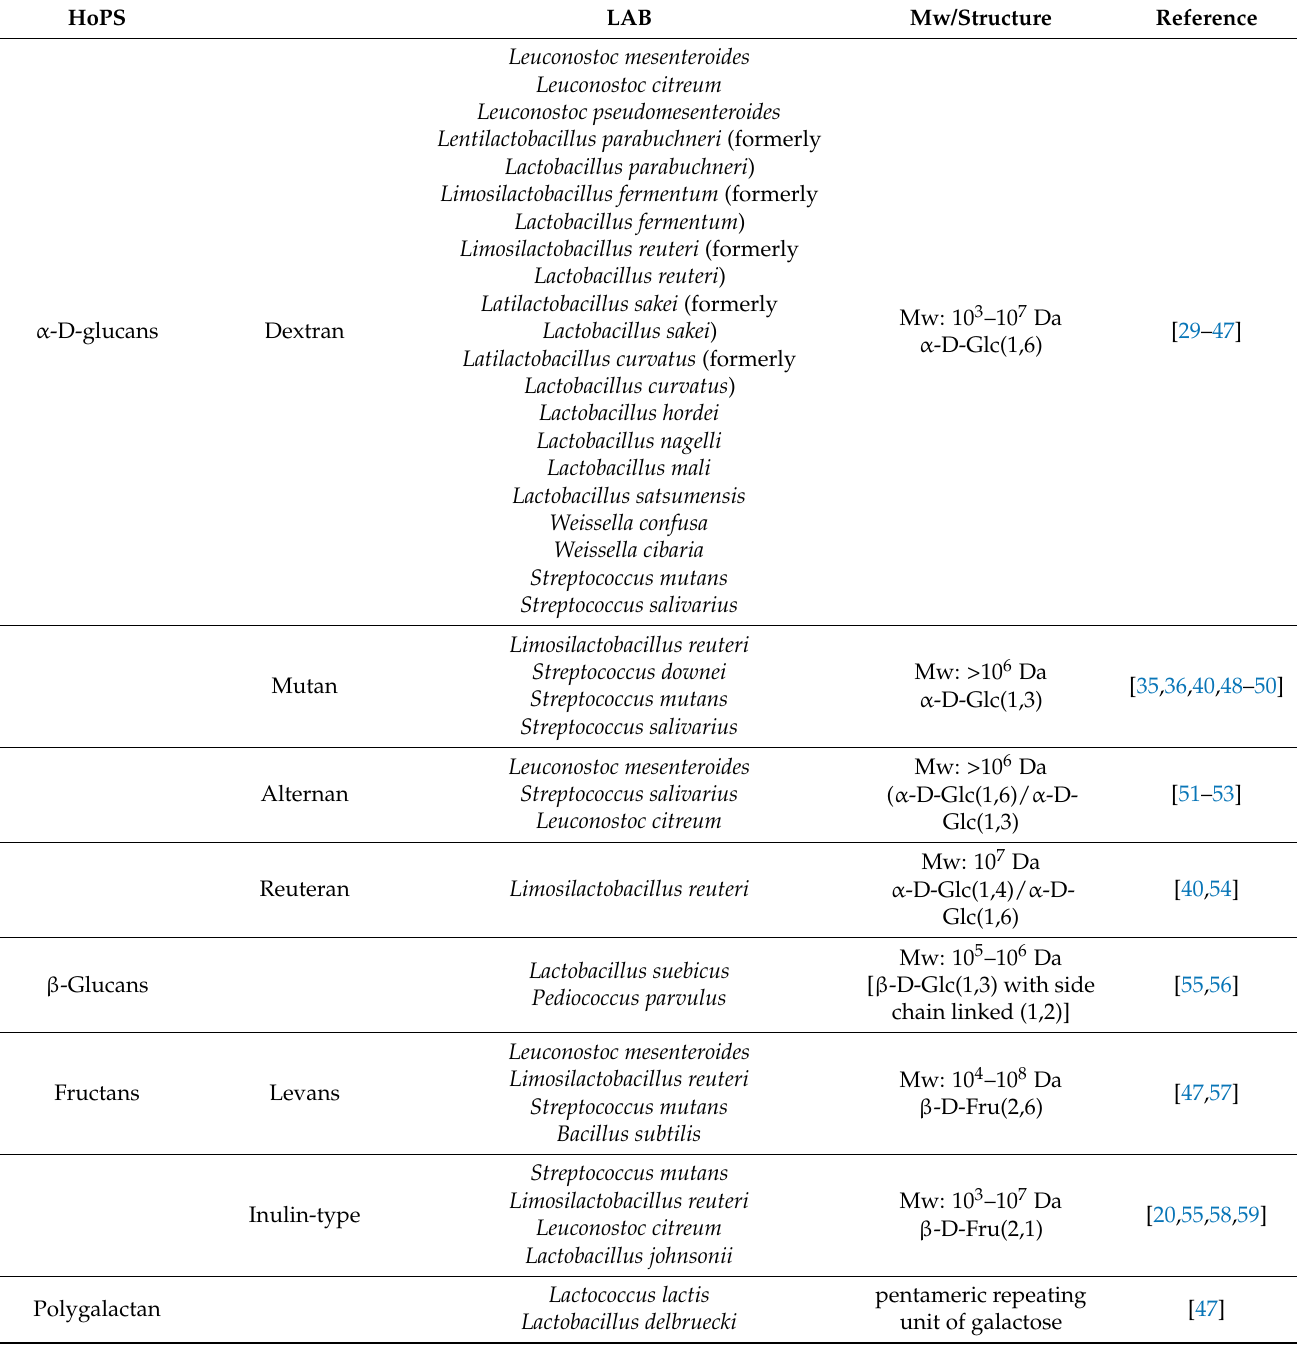
Table 1. Homopolysaccharides produced by lactic acid